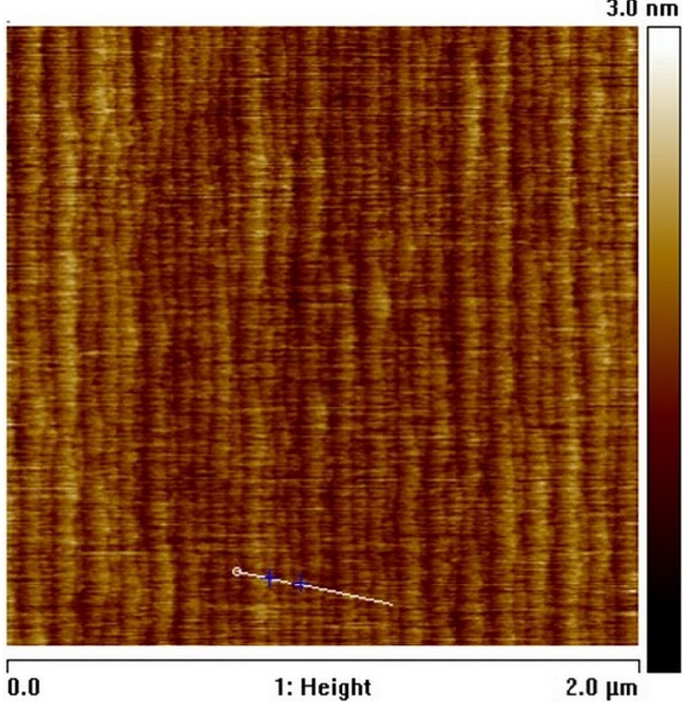
Figure 1. AFM image of as-grown surface of the GaN epilayer.